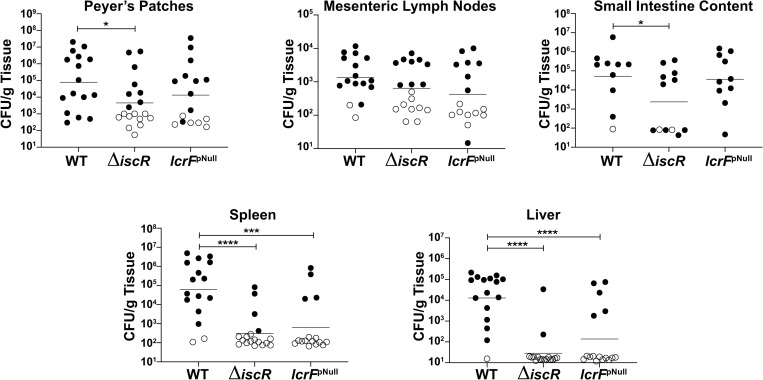
Proper regulation of lcrF by IscR is necessary for disseminated infection.Mice were infected with ~2x108
Y. pseudotuberculosis using a bread feeding model, and organs and intestinal contents harvested 5 days post-inoculation. CFUs were normalized to the weight of the organ in grams. Each symbol represents one animal. Unfilled symbols are set at the limit of detection for each individual organ based on weight, and represent CFU that were below this limit. Graphs show data combined from five independent experiments. **p<0.01, *** p<0.001, ****p <0.0001, as determined by an unpaired Mann-Whitney rank sum test. Dashes represent geometric means.